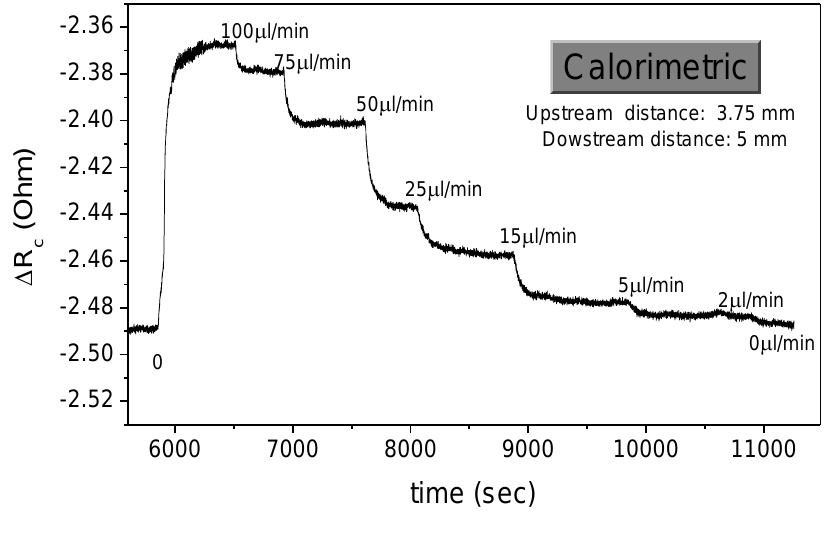
Figure 5. The sensor operation under the calorimetric principle, for D down = 5 mm and D up = 3.75 mm. The real time signal is the change in the resistance value of the sensing elements at the denoted flow rate